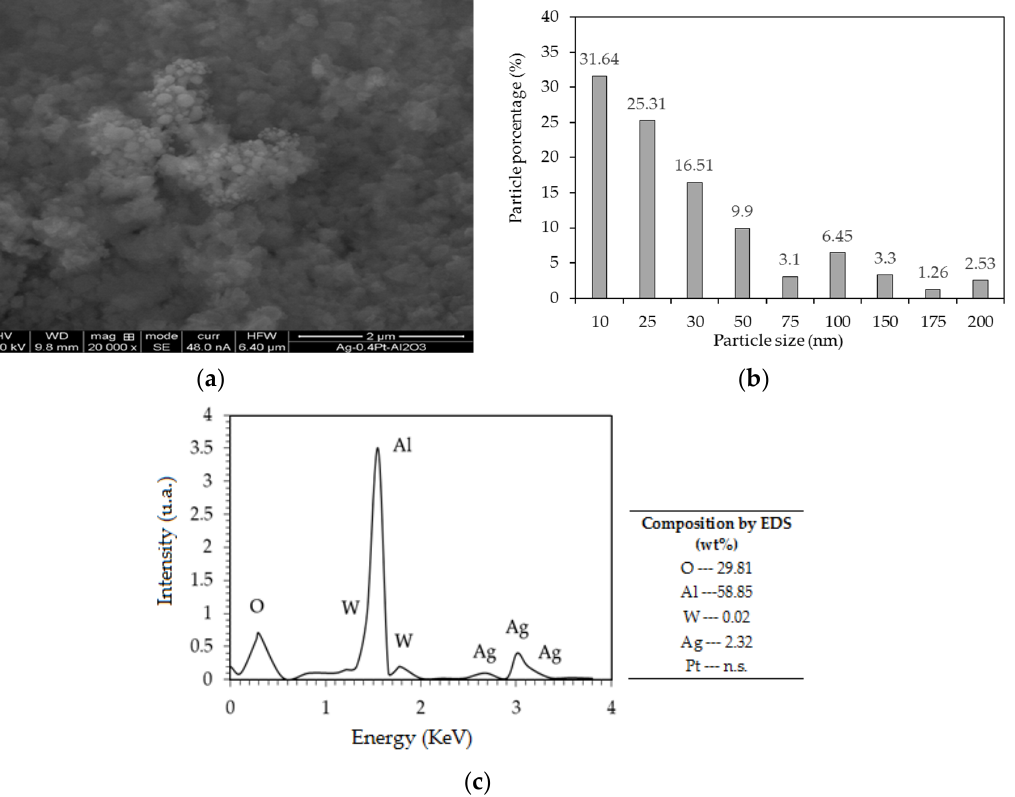
Figure 3. Morphological and chemical composition of the catalyst 0.4PtAg/AW calcined at 500 °C. ( a ) SEM micrograph; ( b ) The distribution of particle diameters; ( c ) EDS analysis of the spherical cumulus zone where Pt cannot be analyzed due to its low concentration.